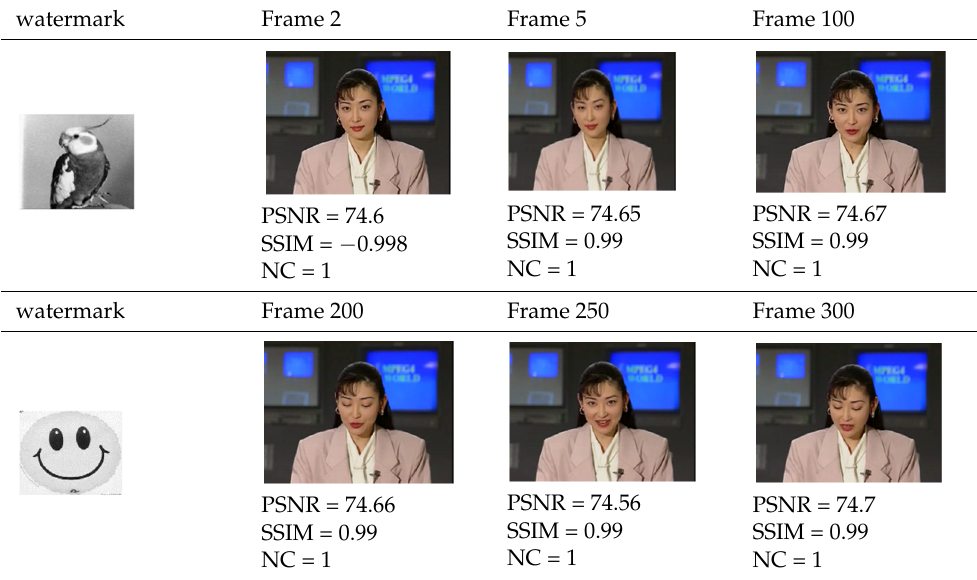
Table 3. PSNR, SSIM, and NC of watermarked “Foreman.mp4”.